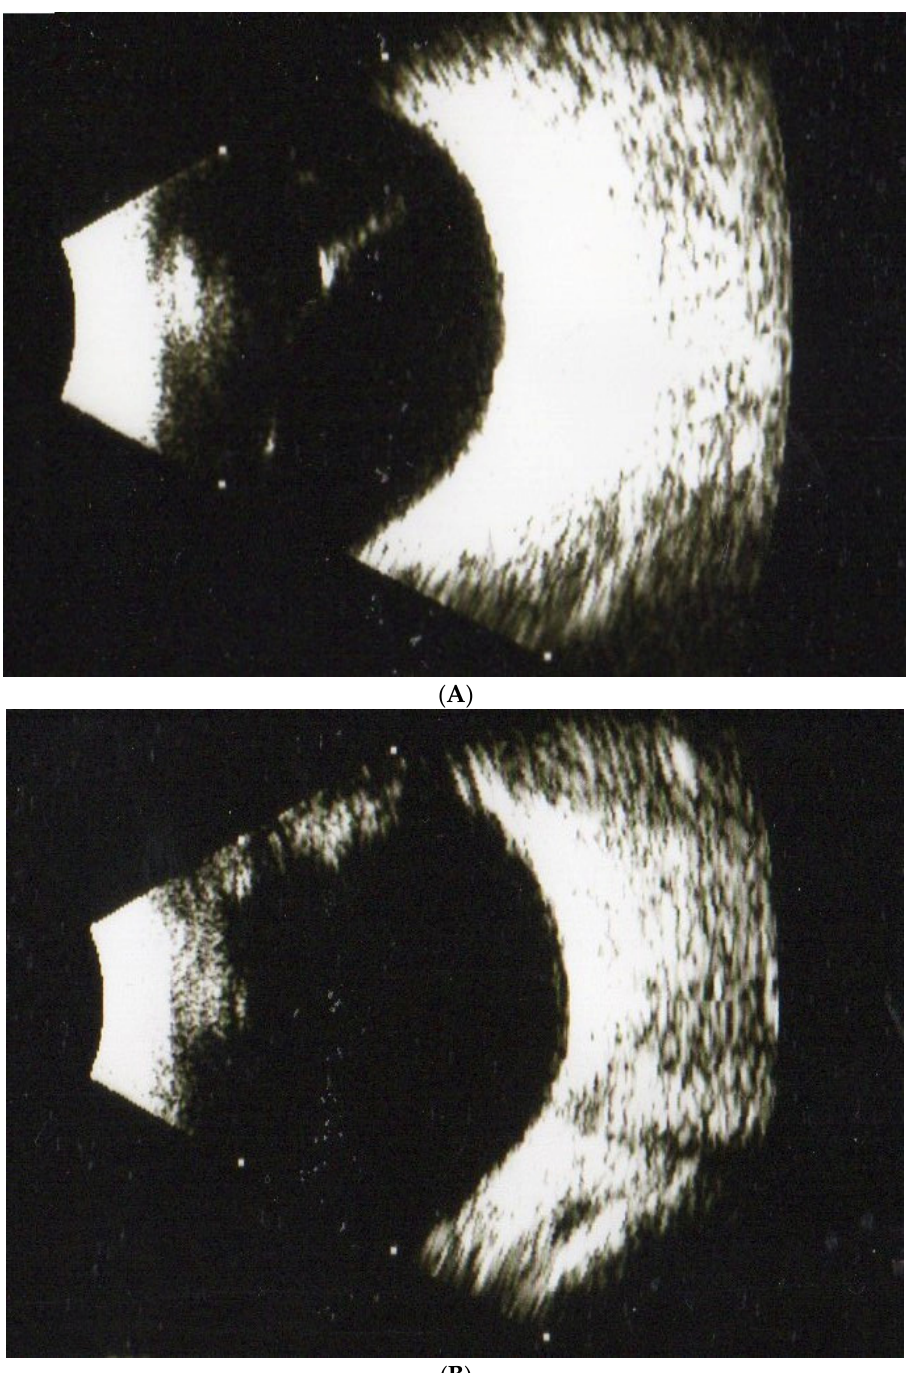
Figure 1. ( A ) A female patient aged 55 with one SVO was diagnosed by ultrasonography (B-scan) at the beginning of our study. ( B ) The SVO from the patient significantly disappeared after 3 months of treatment with mixed fruit enzymes as observed in the B-scan evaluation. In experiment 2, 64 patients with VH-induced ocular floaters suffered from dark-black and even brown-red colors of cloud-like shapes blocking the visual axis. Similarly, we compared the results after three months, in which only HDG revealed a significant disappearance rate (66%), as compared with the baseline ( p < 0.05) (Table 2). Furthermore, we analyzed the change in BCVA at the baseline during a three- month period. We found that only HDG could enhance the improvement in patients’ vision. Pa- tients with VH after HDG (3 capsules daily) intake increased to 0.19 LogMAR compared with the baseline (0.63 log MAR) ( p < 0.05) (Table 3). For example, one patient aged 58 with DM for several